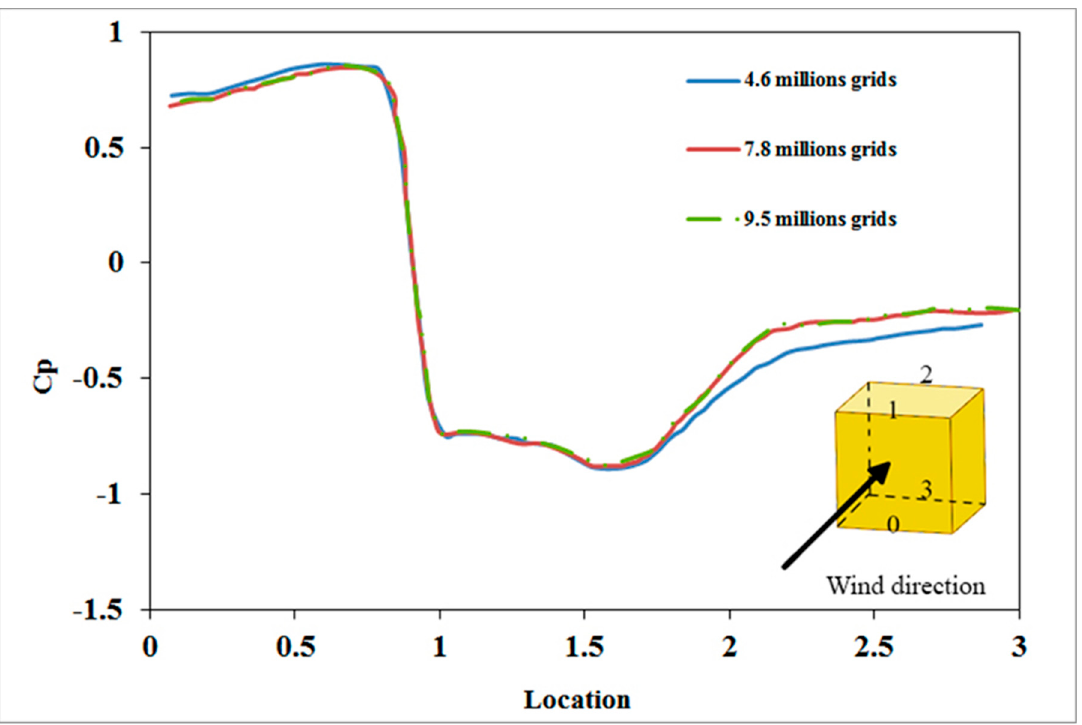
Figure 3. Comparison of the mean pressure coefficient for the three different grids number for the presented study.